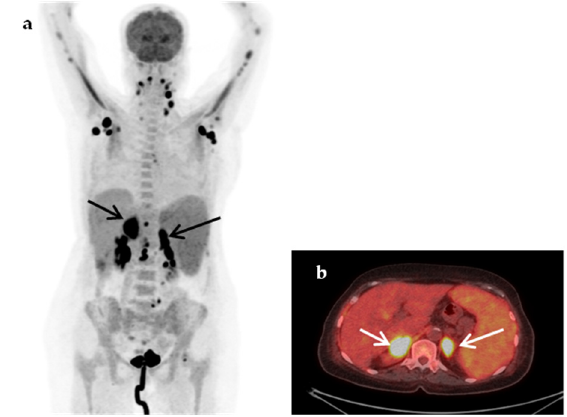
Figure 5. A 75-year-old woman presented with a 4-week fever associated with malaise and weight loss. The abdominal CT revealed splenomegaly and adrenal masses. Maximum-intensity projection (MIP) 18 F-FDG-PET ( a ) showed extensive highly hypermetabolic lymphadenopathy, cervical, axillary (SUVmax 22.7) and abdominal and hypermetabolic (SUVmax 16.8) adrenal masses (fused transaxial 18 F-FDG-PET/CT image ( b ), arrows), hypermetabolic hepatic lesions (at least two) and multiple hypermetabolic bone metastases and splenomegaly with diffuse homogeneously increased metabolic activity. The findings were suspicious of lymphoma. A diagnosis of non-Hodgkin’s lymphoma was confirmed by histopathology after biopsy of an axillary lymph node. J. Clin. Med. 2020 , 9 , x FOR PEER REVIEW